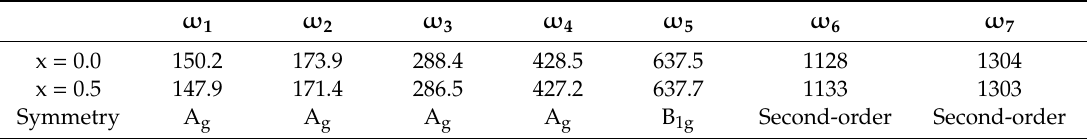
Table 4. Frequency and symmetry assignment of some specific Raman-active phonon modes ( ω